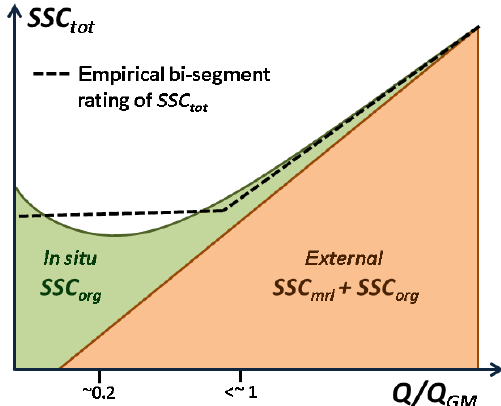
(iii) the gradient of the modeled SSC tot lines continuously